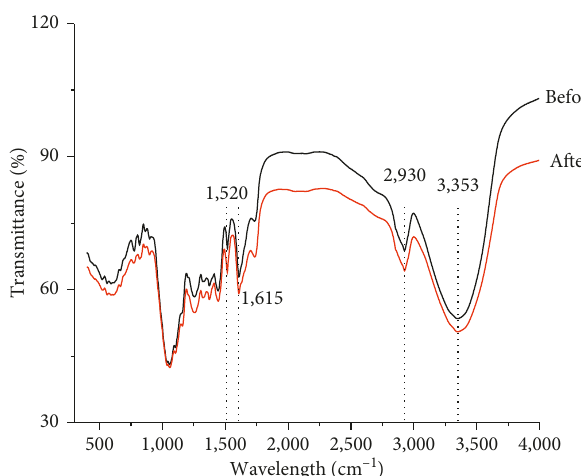
Figure 1: FTIR vibrational spectra of epicarp of green coconut (before and after adsorption).